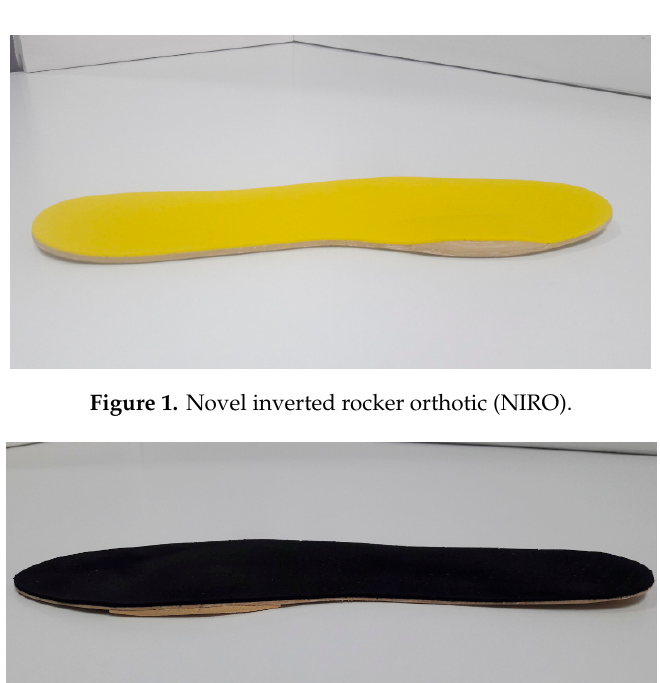
Figure 2. Typical Morton’s extension orthotic (TMEO).